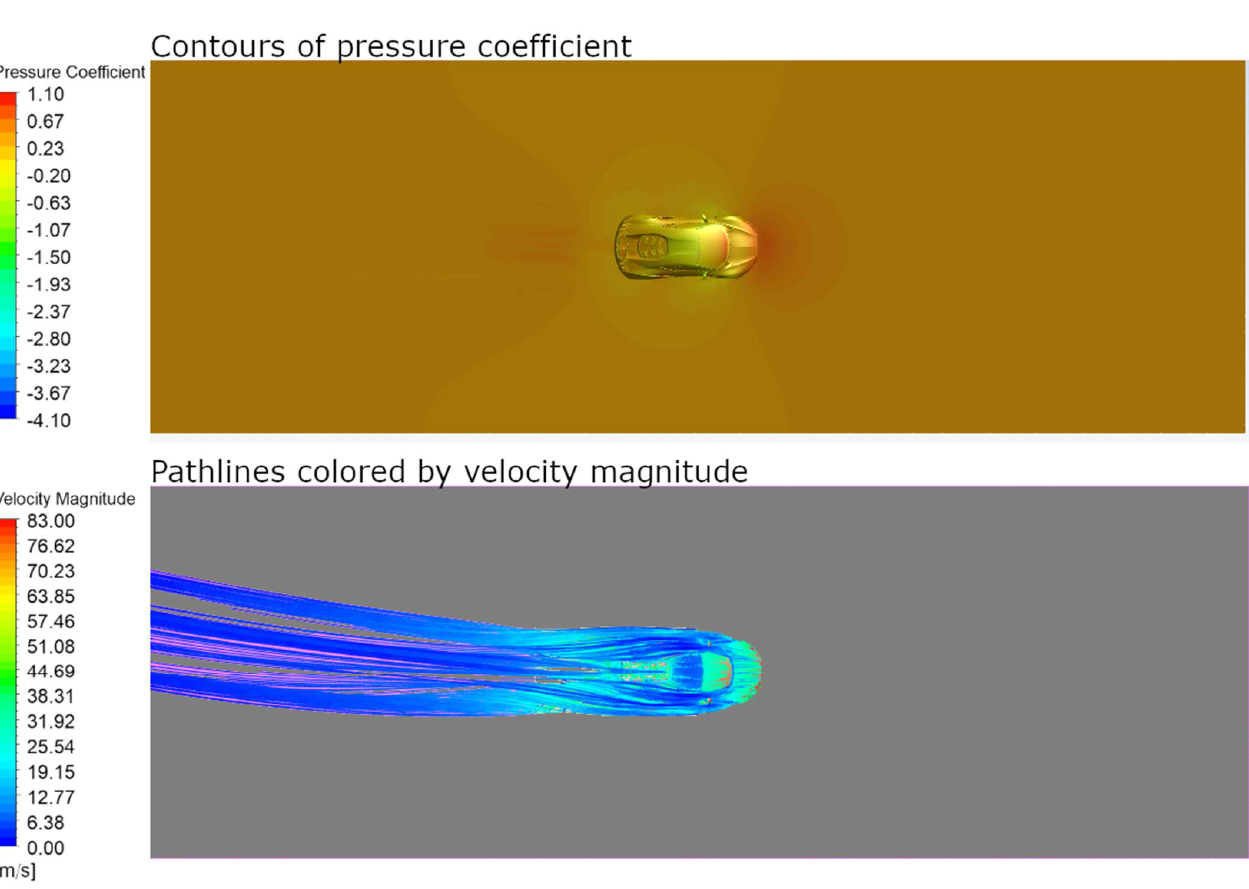
Figure 4. Visualization of the ratio of computational domain size to car size